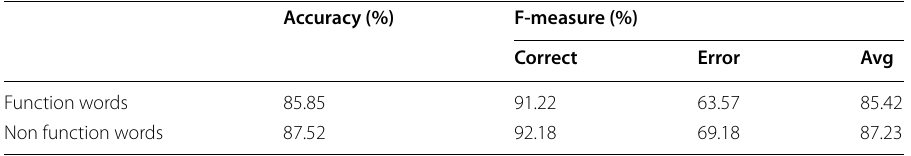
Table 7 Function and non function words analysis on the test set